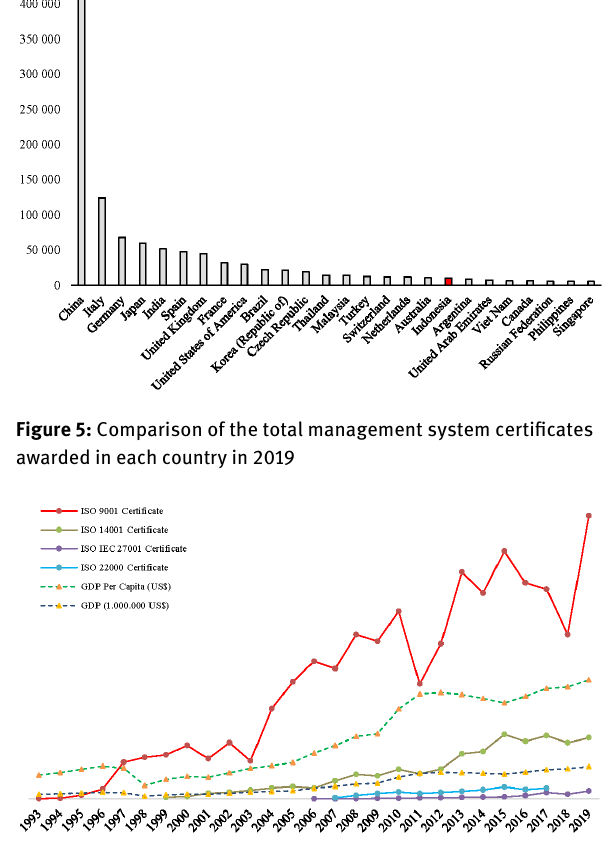
imise risk to employees and other interested parties who may be exposed to occupational health and safety risks associated with its activities